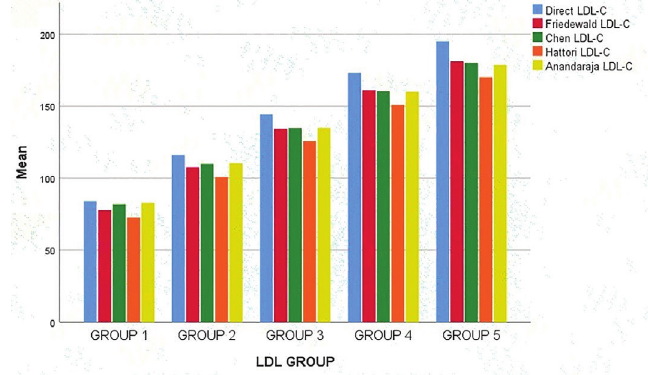
Figure 3 - Comparison of direct LDL-C measurement with Friedewald, Chen, Hattori and Anandaraja formulas in LDL-C